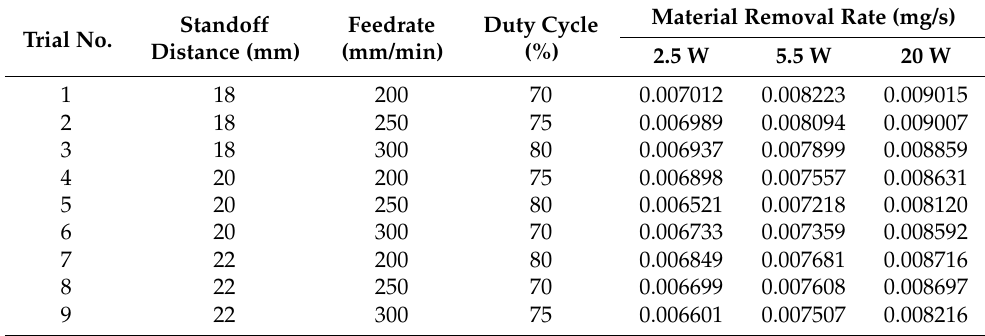
Table 3. Effect of diode laser on